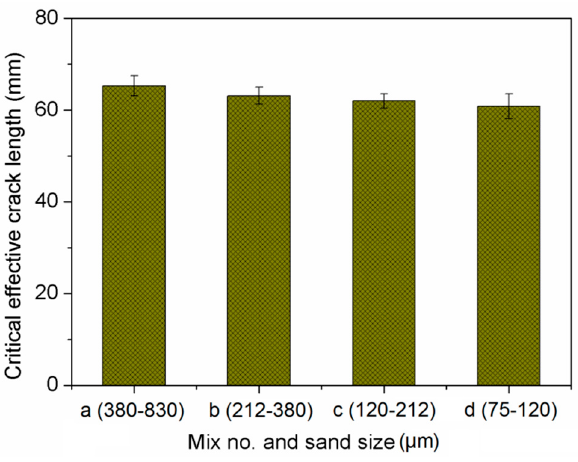
Materials 2020 , 13 , x FOR PEER REVIEW Figure 13. Fracture energy of cement-based composites. Figure 13. Fracture energy of cement-based composites.